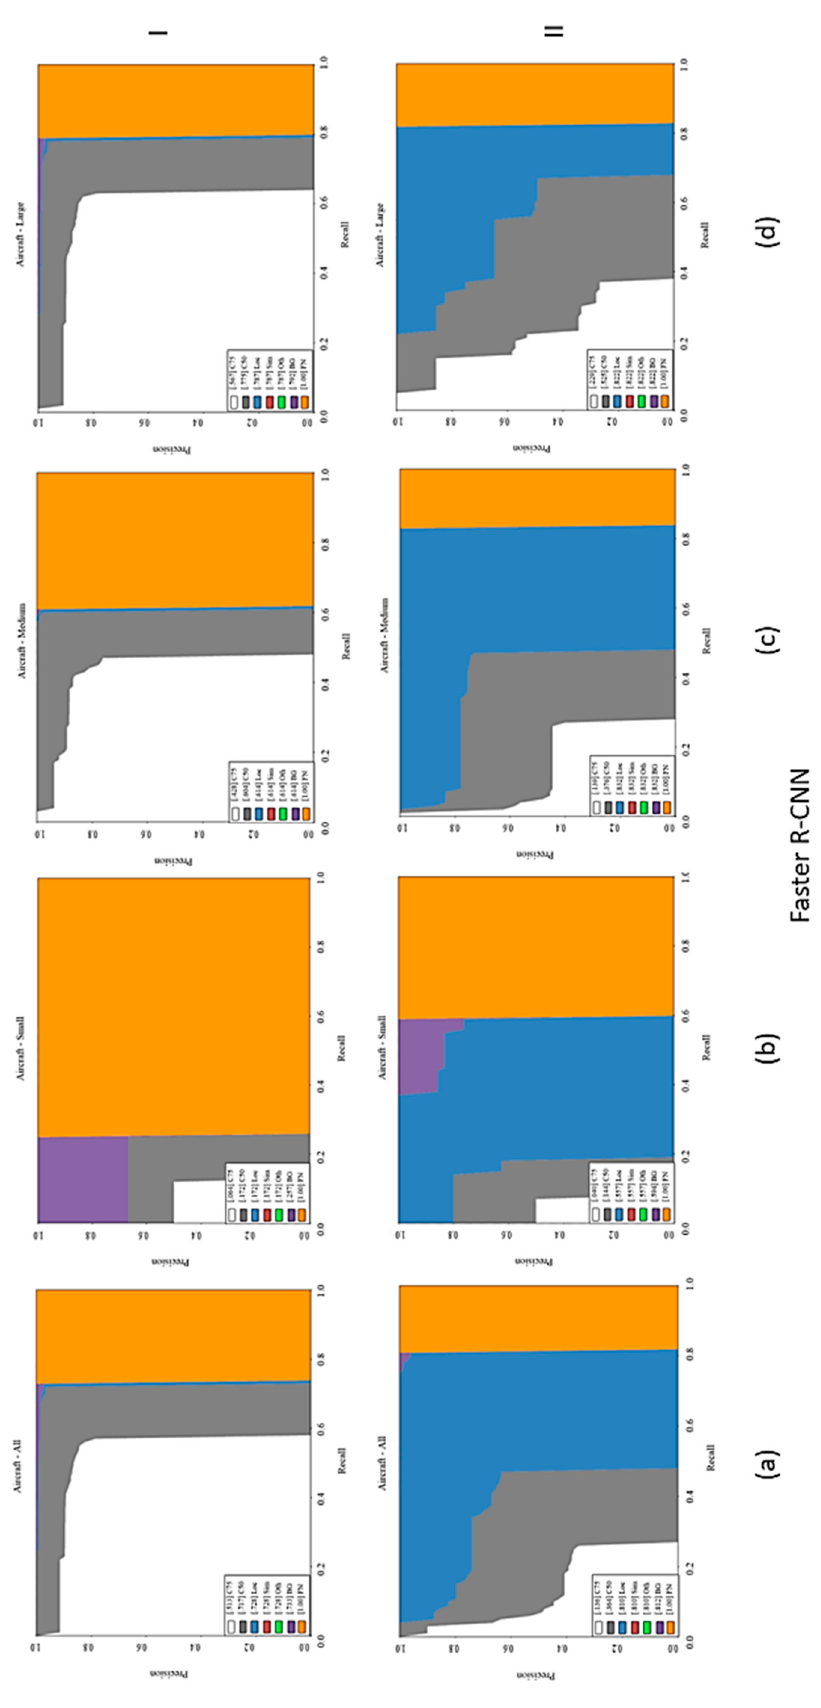
Figure A3. Faster R-CNN Precision–recall curves for, ( a ) all object sizes, ( b ) small, ( c ) medium, ( d ) large object size obtained from, (I) DOTA test data and (II) Pleiades large-scale test image data.